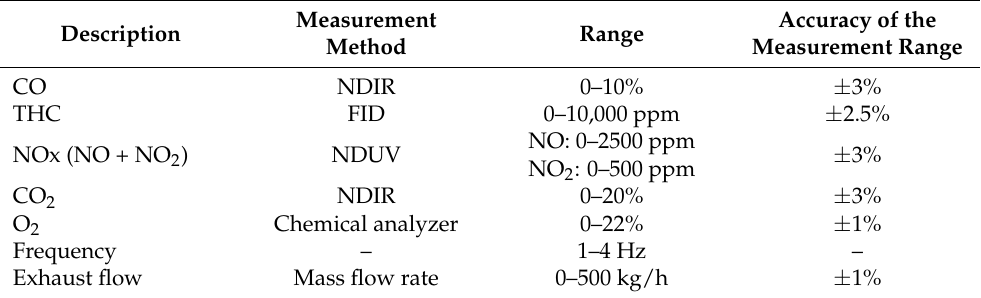
Table 4. Technical parameters of the measurement equipment (SEMTECH DS).